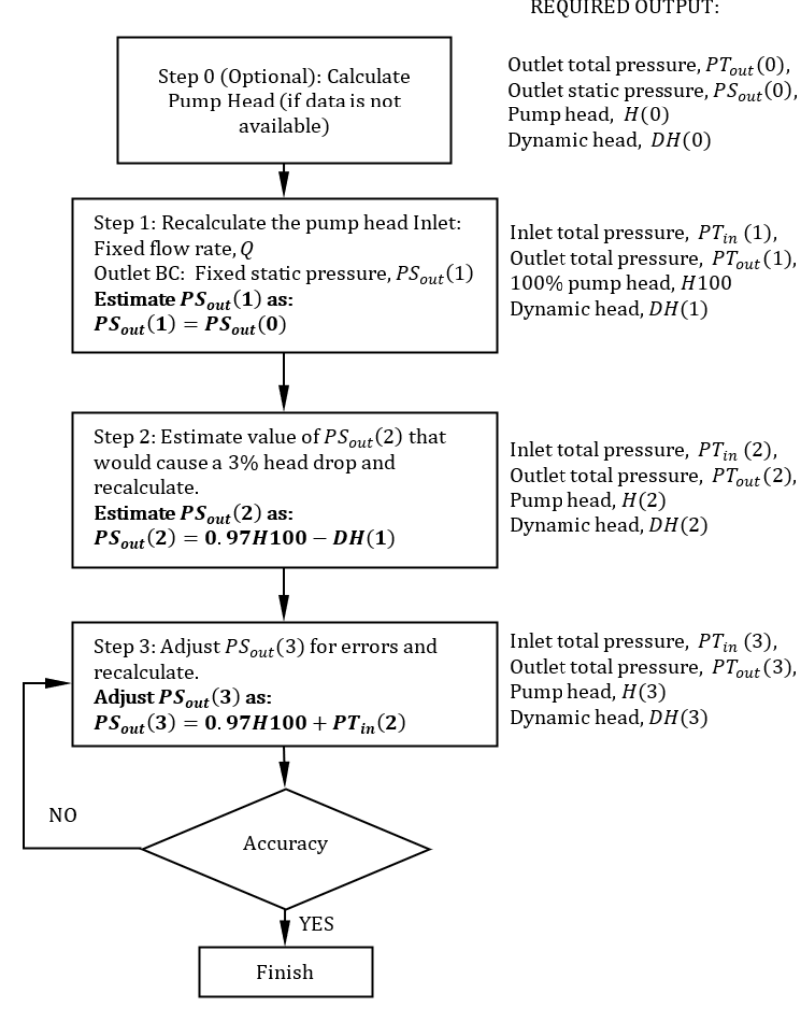
Figure 3. Procedure for calculating NPHR3 as proposed by Ding et al. [14].